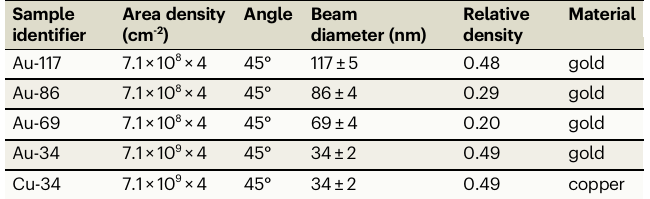
Table 1 | Main parameters of the quasi-BCC nanolattices Sample identi fi er